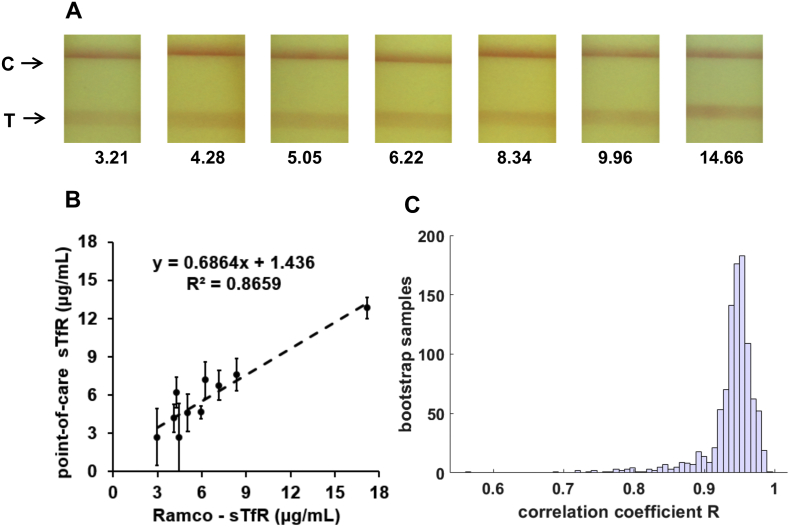
(A) Representative images of the test and control lines on the sTfR test strip for a range of concentrations of serum samples (B) Correlation plot of predicted serum sTfR concentrations based on comparison of point-of-care test results with Ramco ELISA (C) Results of bootstrapping to compute the resulting correlation coefficients.